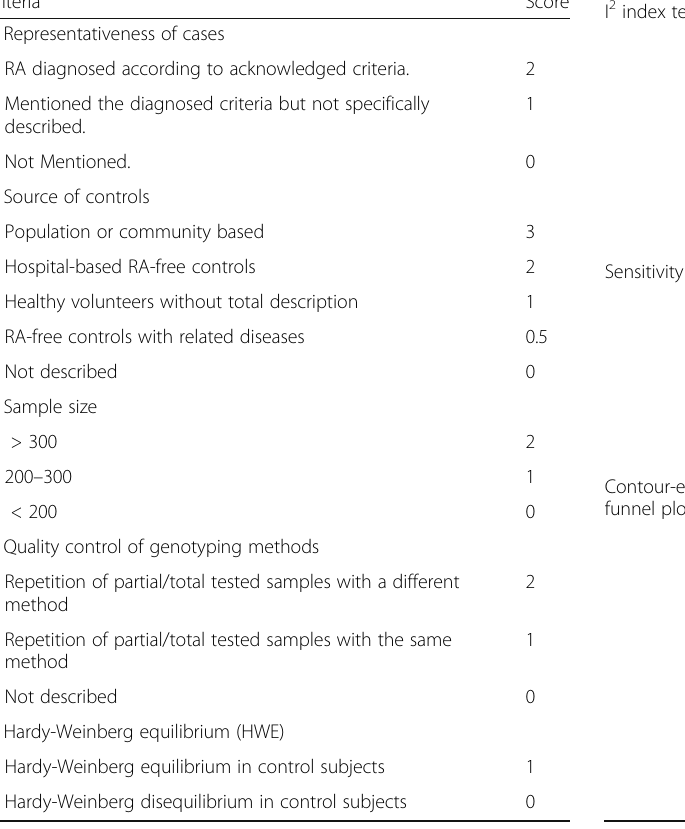
Table 3 Scale for methodological quality assessment Criteria